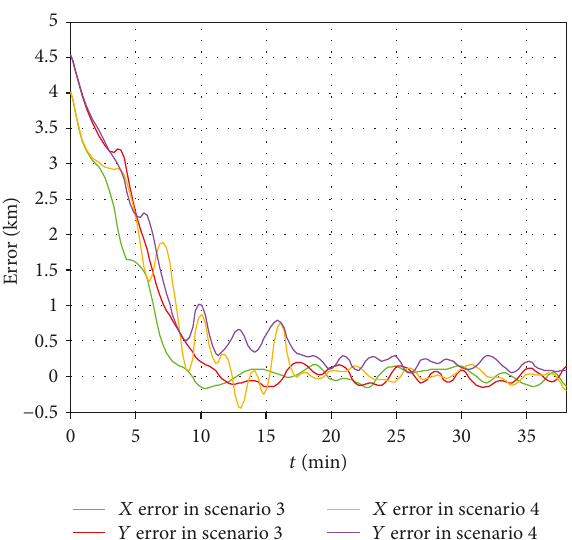
Figure 4: Static target tracking in scenario 2.